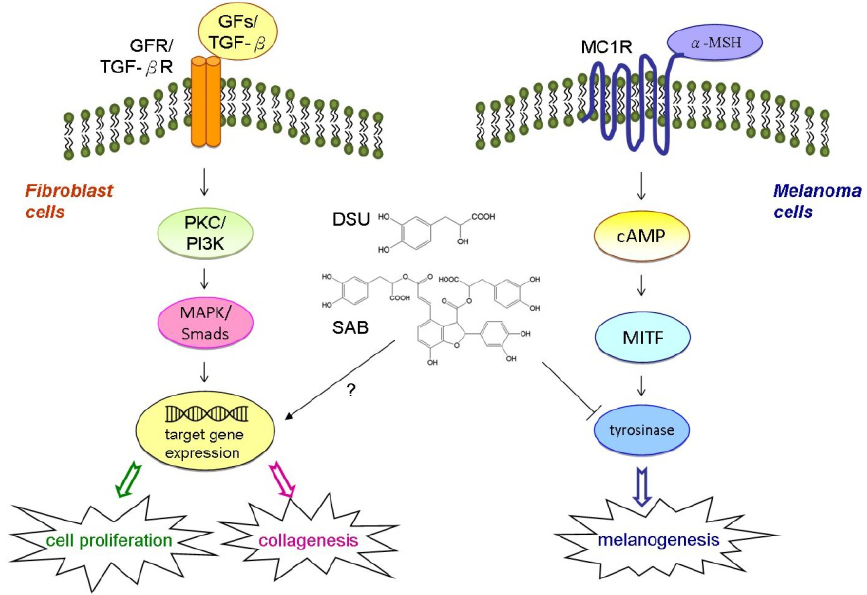
Figure 8. Proposed mechanisms of danshensu (DSU) and salvianolic acid B (SAB) on cell proliferation and collagen and melanin